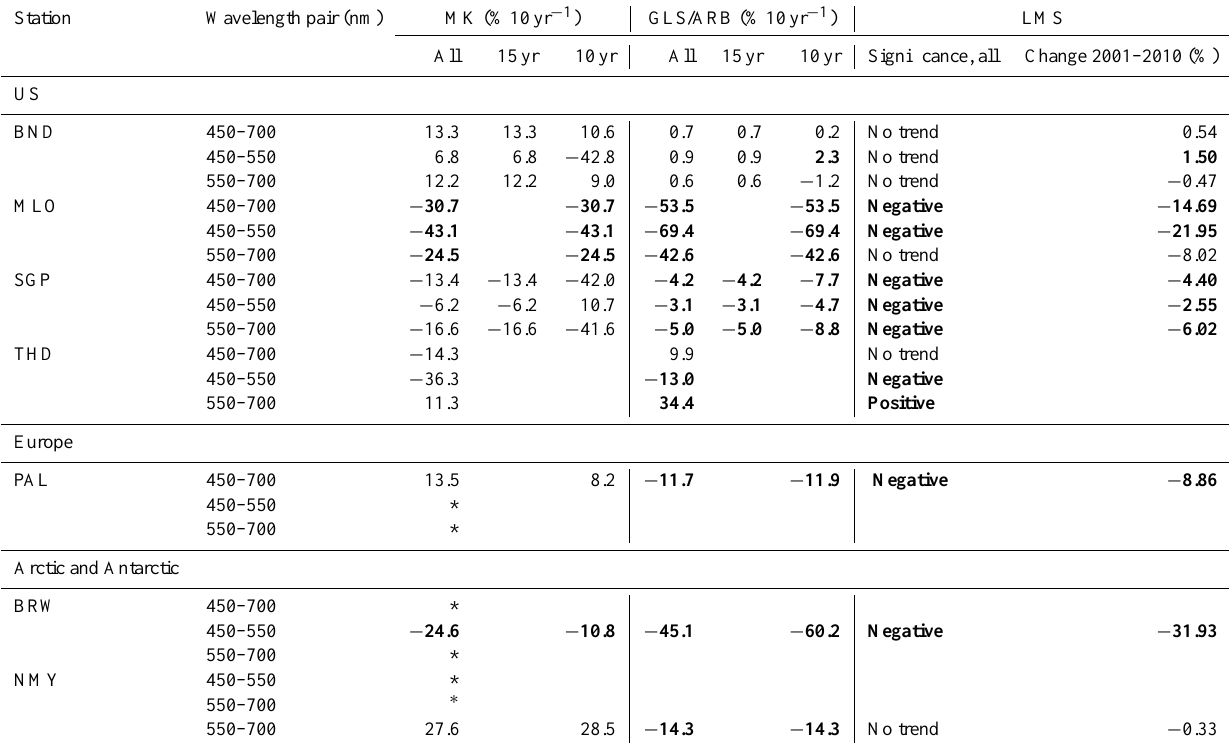
Significance, all Change 2001–2010 (%)